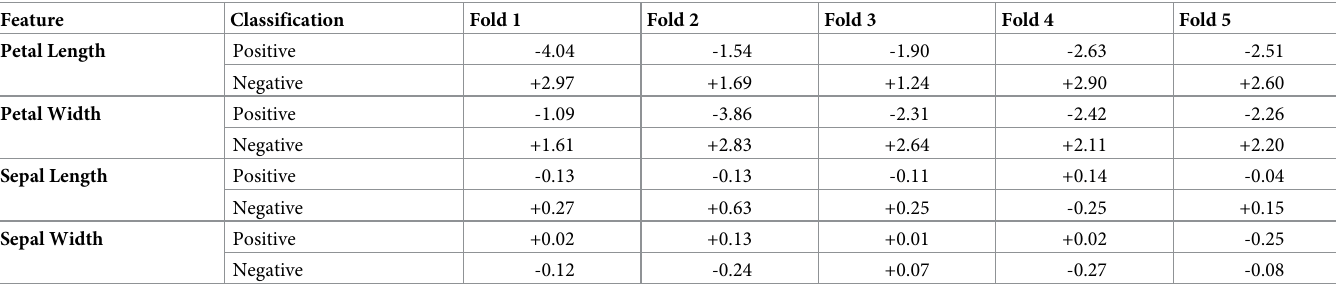
Table 3. 5-fold feature contribution average for positive and negative classification of the Iris dataset using HOTS.